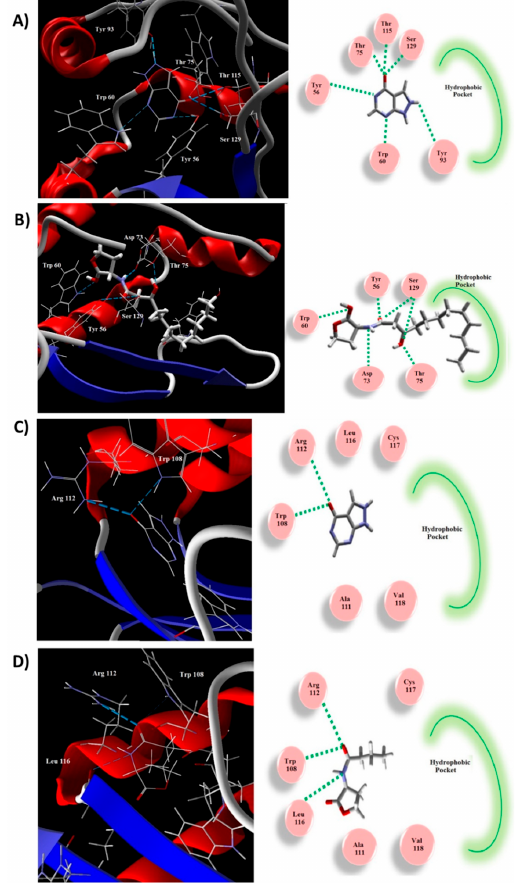
Figure 8. In silico allopurinol binding to QS receptors. ( A , C ) The molecular docking of allopurinol into the LasR and RhlR receptors’ active sites, respectively; 3D (Left) and 2D schematic views of the binding (Right). ( B , D ) The molecular docking of natural ligand into the active site of LasR and RhlR receptors, respectively; 3D (Left) and 2D schematic views of the binding (Right). Allopurinol binds efficiently to QS receptors and clearly exerts antagonist